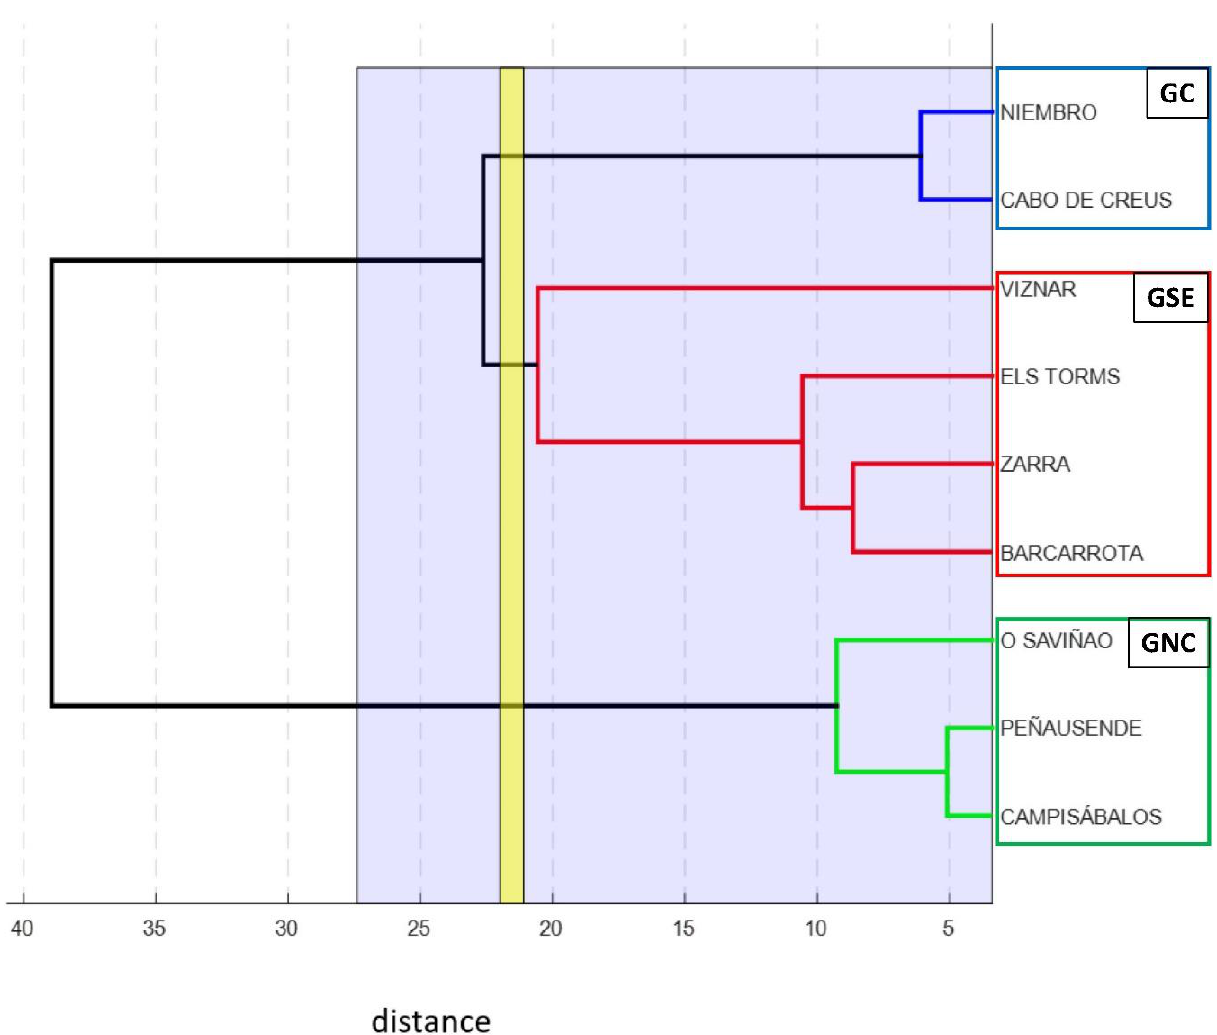
Figure 2. Dendrogram showing the clusters regarding similarities in PM 10 monthly concentration values.